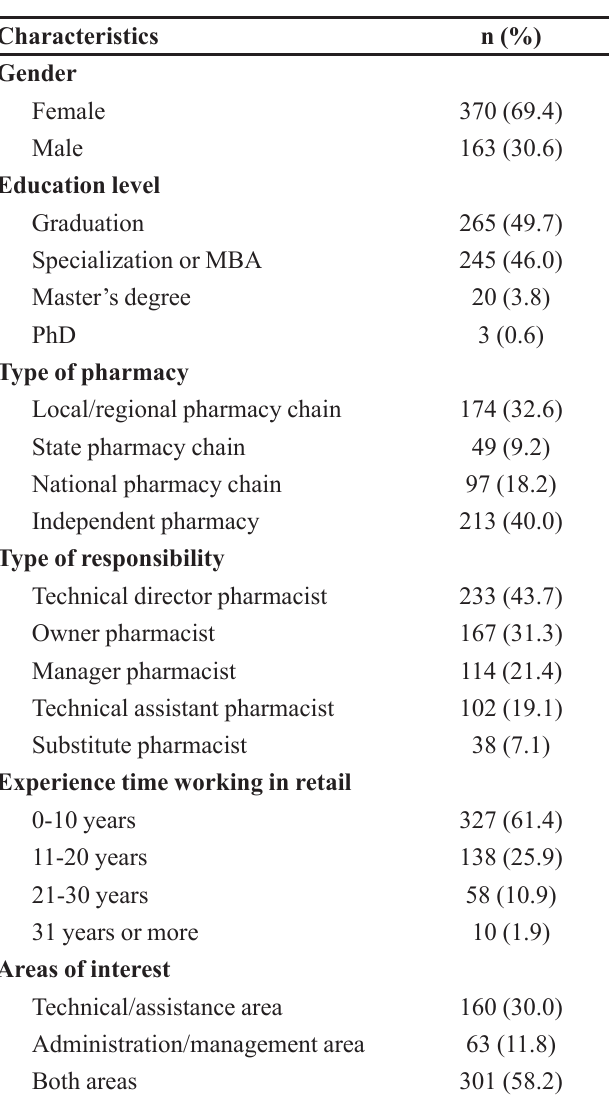
TABLE I - Profile of pharmacists in the State of Paraná (n=533)